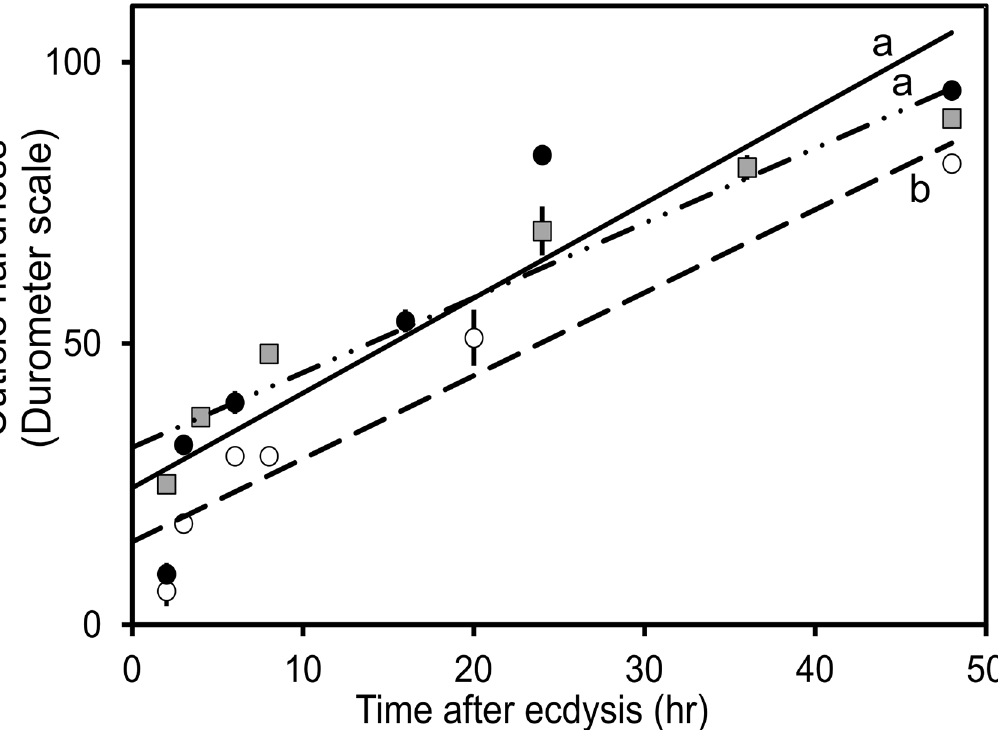
Fig 2. Shell-hardness of the new cuticle during 48 hrs after ecdysis. Intermolt crabs (n = 7) were injected with 10 μ g of CasPPO-hemo-dsRNA every other day until ecdysis and the hardness of the postmolt cuticle was measured by a hand-held durometer (durometer scale = 0 – 100 DU). Dashed line = CasPPO-hemo-dsRNA injected group (R 2 = 0.93), solid line = control saline (R 2 = 0.84), and dashed-dot line = control dsRNA (R 2 = 0.94). ANCOVA analysis of general linear models (Y = a + bX) shows a significant difference ( P < 0.05, noted with different letters) in the hardening of the cuticle of PPO - dsRNA injected and control crabs (n = 7). The data are shown as mean ± SE